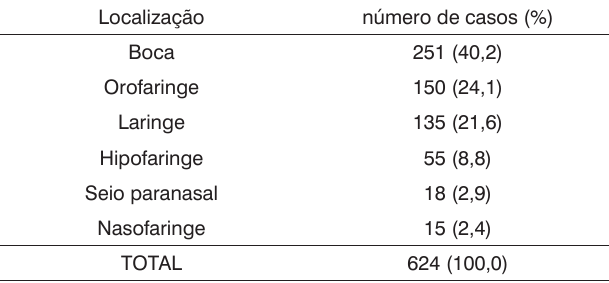
Figura 1. Frequência cumulativa de diagnósticos de segundo tumor pri- mário em relação ao período de seguimento dos 624 casos analisados. Tabela 3. Distribuição dos casos de segundo tumor primário de acordo com a localização.